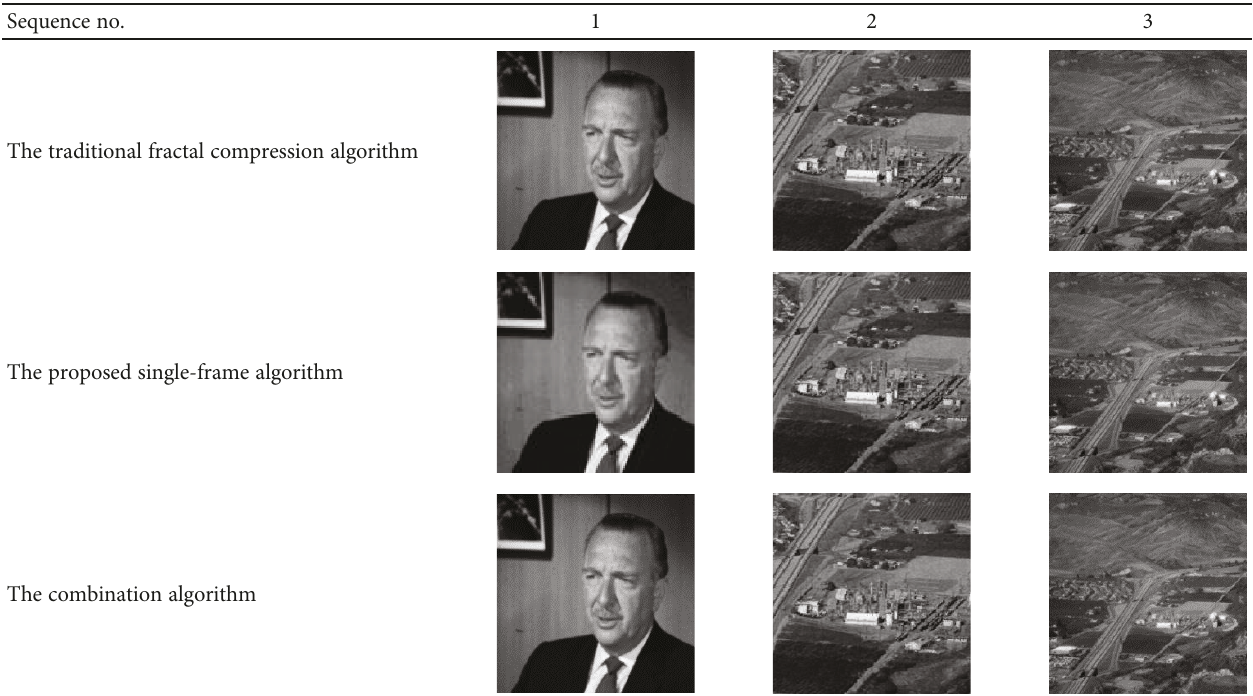
Table 4: Comparison of decoding e ff ects of three